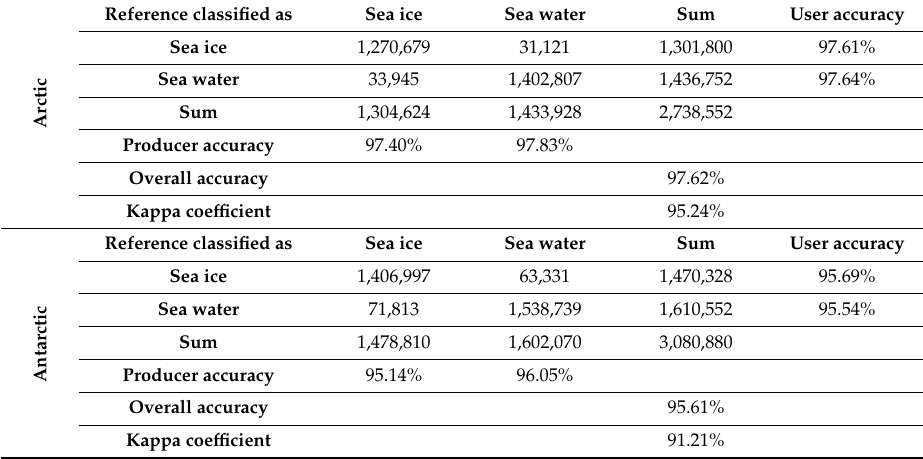
Table 4. The confusion matrix for the Support Vector Machine (SVM) algorithm using data from Arctic and Antarctic